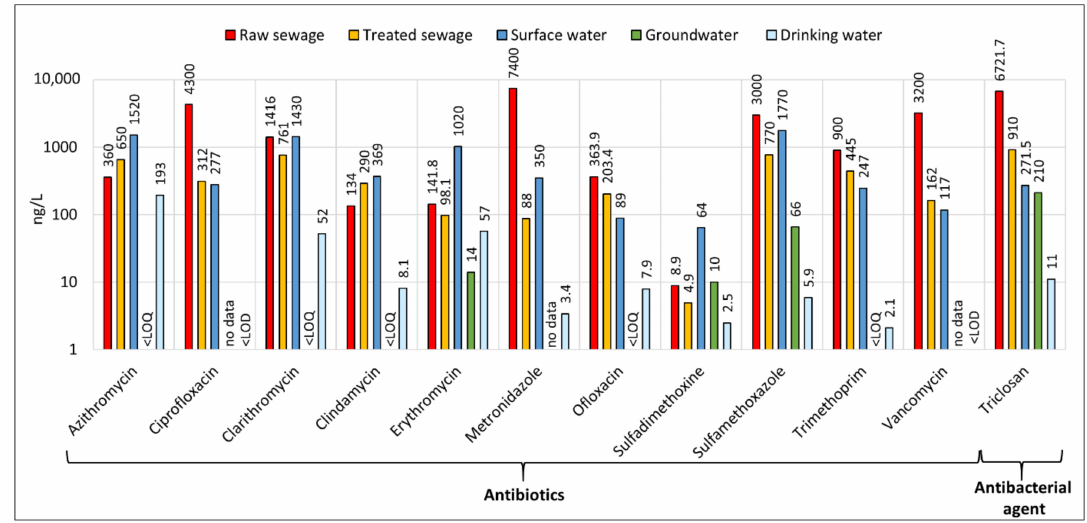
Figure 4. Variations in maximum concentrations of selected antibiotics and one of the antibacterial agents in different water sample